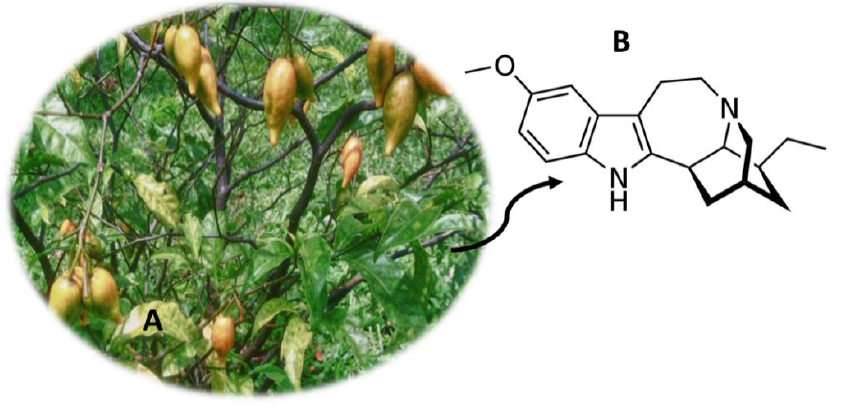
Figure 12. Tabernanthe iboga ( A ) and the main compound ibogaine ( B ).